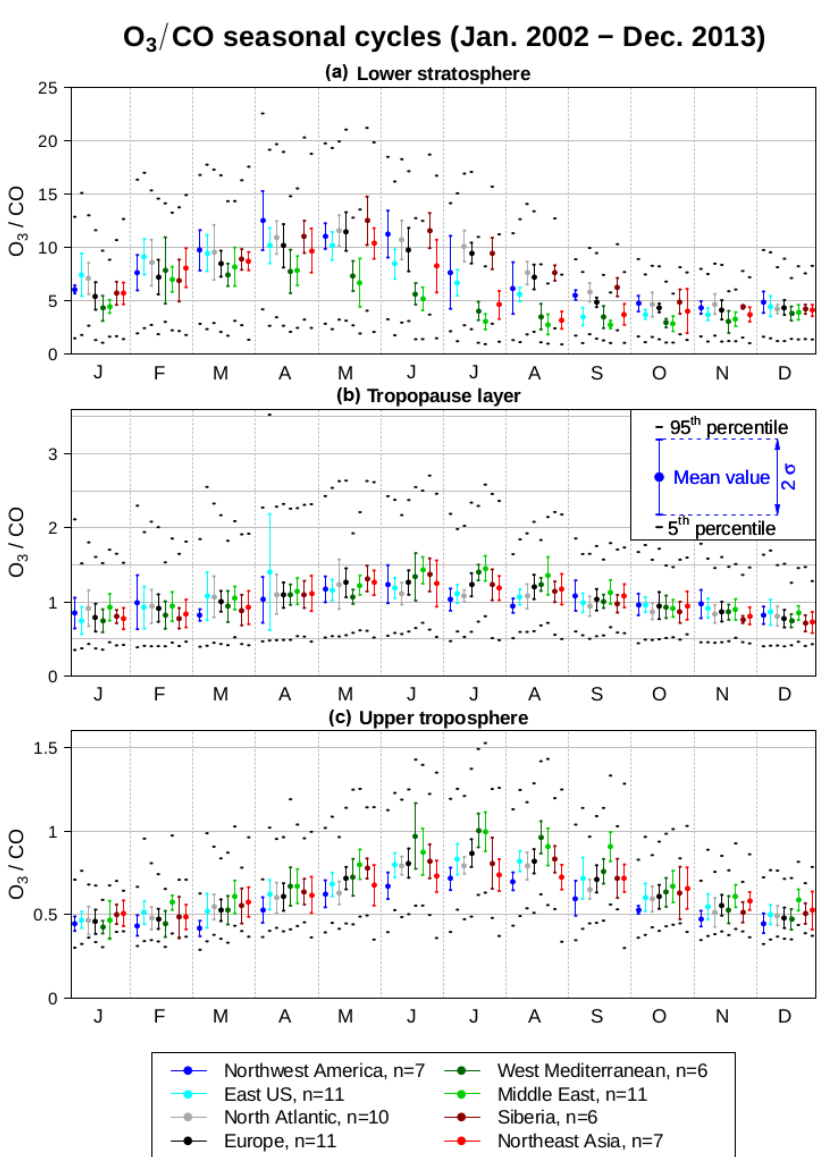
Figure 9. Seasonal cycles of the O 3 / CO ratio for the monthly mean value (coloured points) and the 5th and 95th percentiles (lower and upper black ticks respectively). The interannual variability (coloured error bars) corresponds to the interannual standard deviation of the monthly mean value σ . From bottom to top, the graphs represent the cycles in the upper troposphere, tropopause layer, and lower stratosphere. The amount of years taken into account in the calculation of the upper-tropospheric O 3 / CO cycles is indicated in the bottom legend as the number n